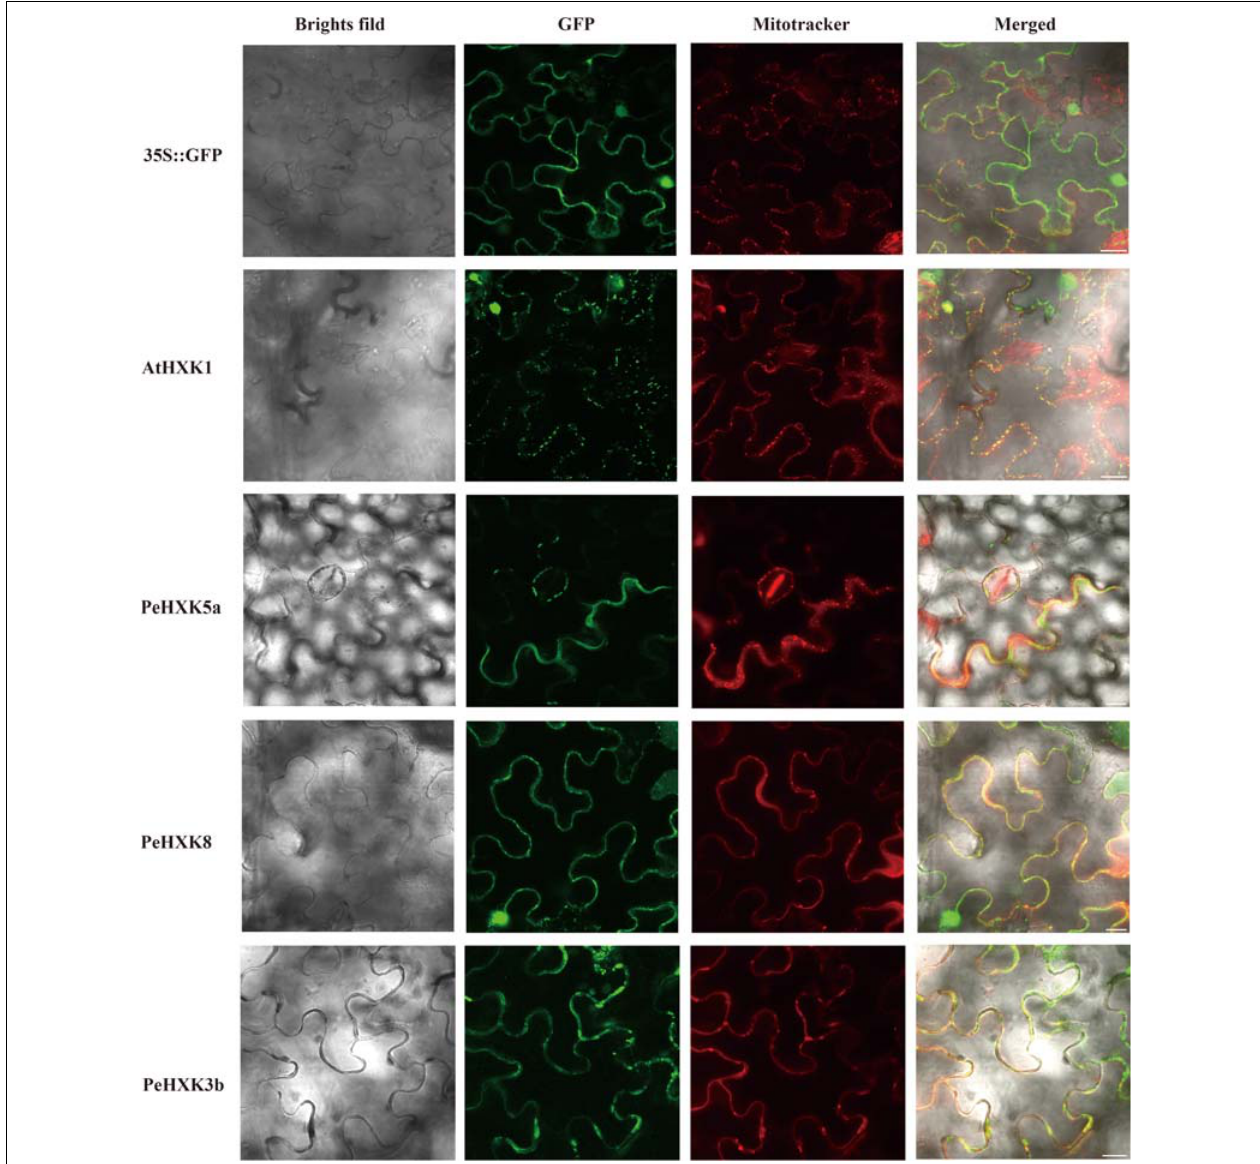
FIGURE 6 | Subcellular location of the PeHXK5a-GFP, PeHXK8-GFP, and PeHXK3b-GFP fusion proteins in tobacco leaves. AtHKX1-GFP and empty vector (pCambia2300GFP) are used as the positive and negative control, respectively. The fluorescence signals were collected by confocal scanning microscopy before pretreatment of dyeing by Mitotracker (red). The merged image was a superposition signals of bright field, GFP and mitotracker signal. Bar = 20 µ